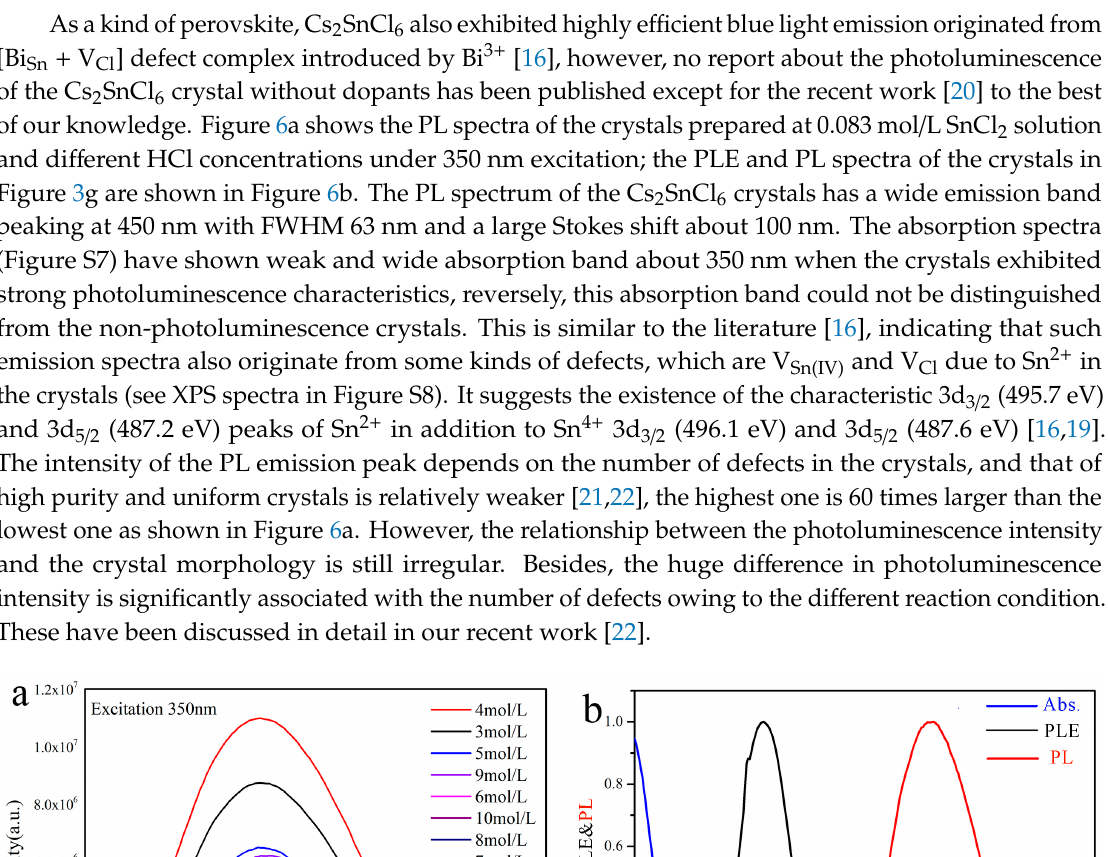
Figure 5. The summary flowchart of the crystal morphologies and synthesis conditions.